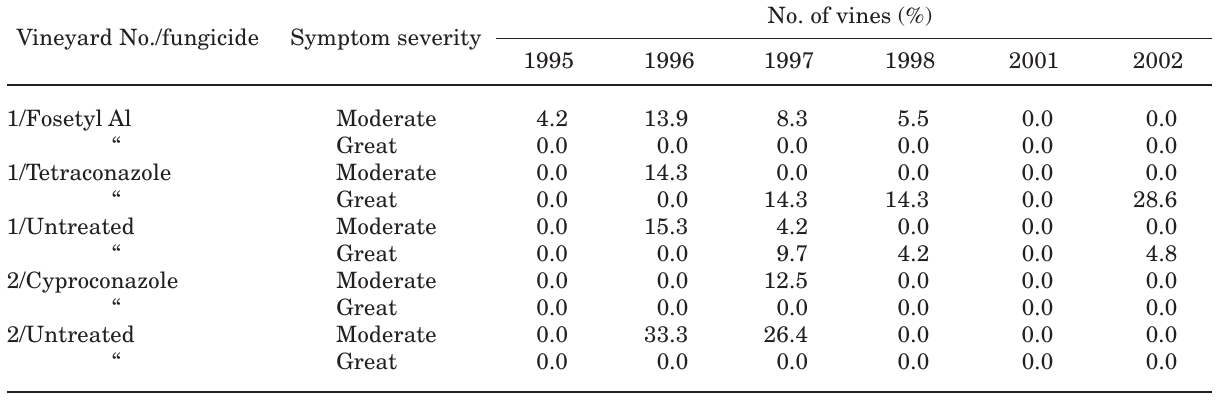
Table 7. Foliar symptom severity.